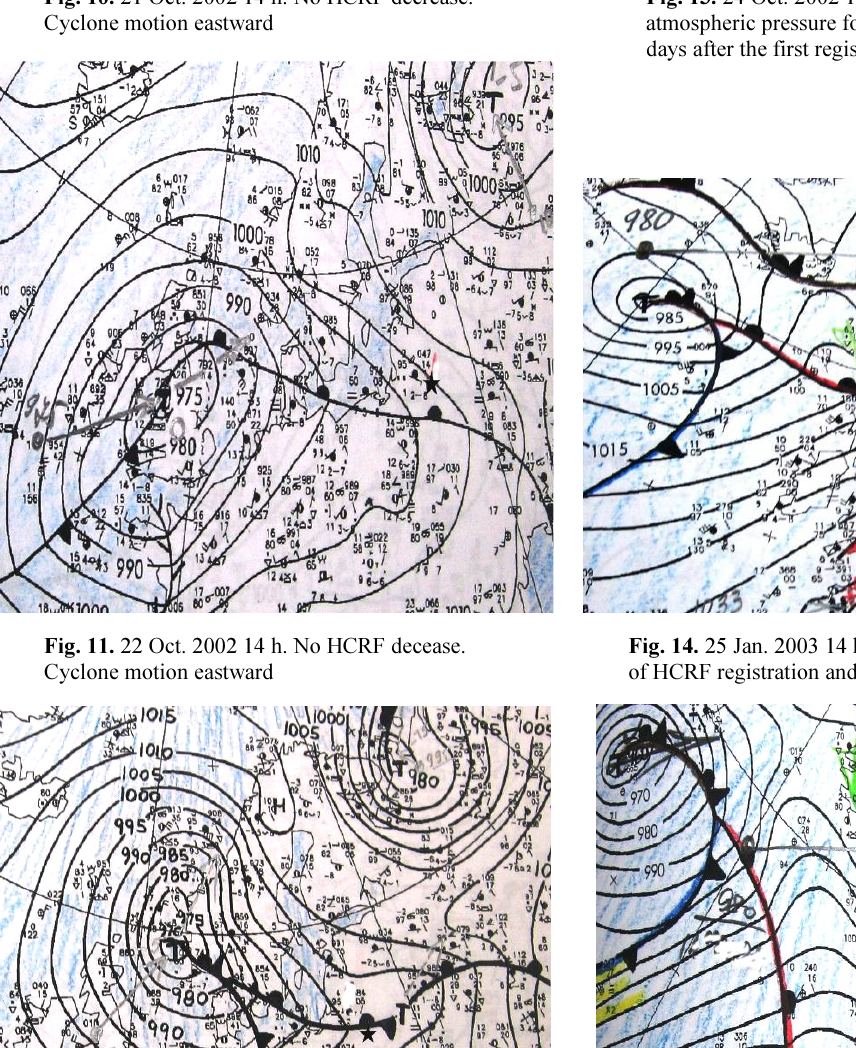
Fig. 10. 21 Oct. 2002 14 h. No HCRF decrease. Fig. 13. 24 Oct. 2002 14 h. No HRCF decrease. Minimum